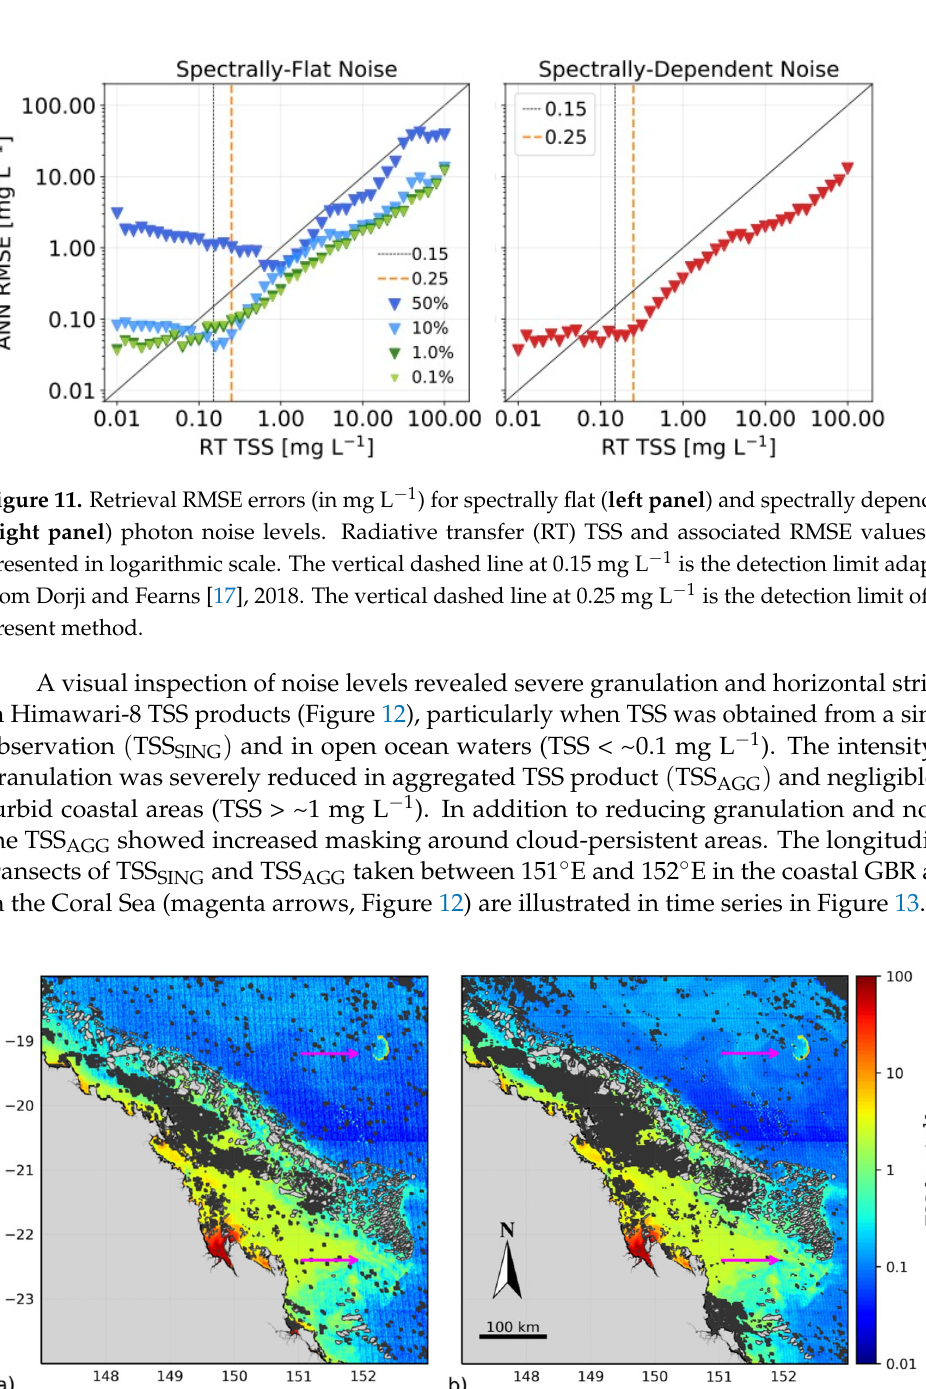
Figure 12. Location of transects (magenta arrows) extracted for TSS (cid:2903)(cid:2893)(cid:2898)(cid:2891) ( a ) and TSS (cid:2885)(cid:2891)(cid:2891) ( b ). Note the cumulative cloud masking in TSS (cid:2885)(cid:2891)(cid:2891) . Himawari ‐ 8 observations taken on 9 September 2017 be ‐ tween 10:00 and 10:50 local time (AEST). TSS TSS (cid:2903)(cid:2893)(cid:2898)(cid:2891) and (cid:2885)(cid:2891)(cid:2891) values mostly below the detection limits of the method (0.25 mg L − 1 ), which may present retrieval errors over 100%. TSS (cid:2903)(cid:2893)(cid:2898)(cid:2891) presented spikes or different or ‐ ders of magnitude values occurring successively on a pixel scale (or within 1 km). As a